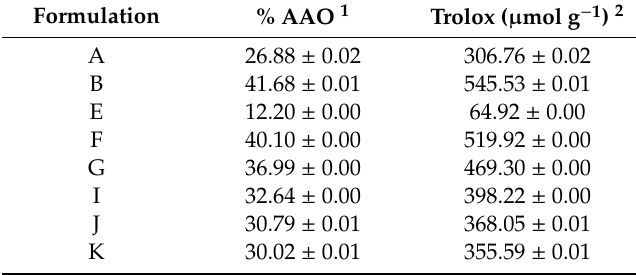
Table 5. Antioxidant activity of the formulations containing grape pomace ( V. vinifera L.) by the